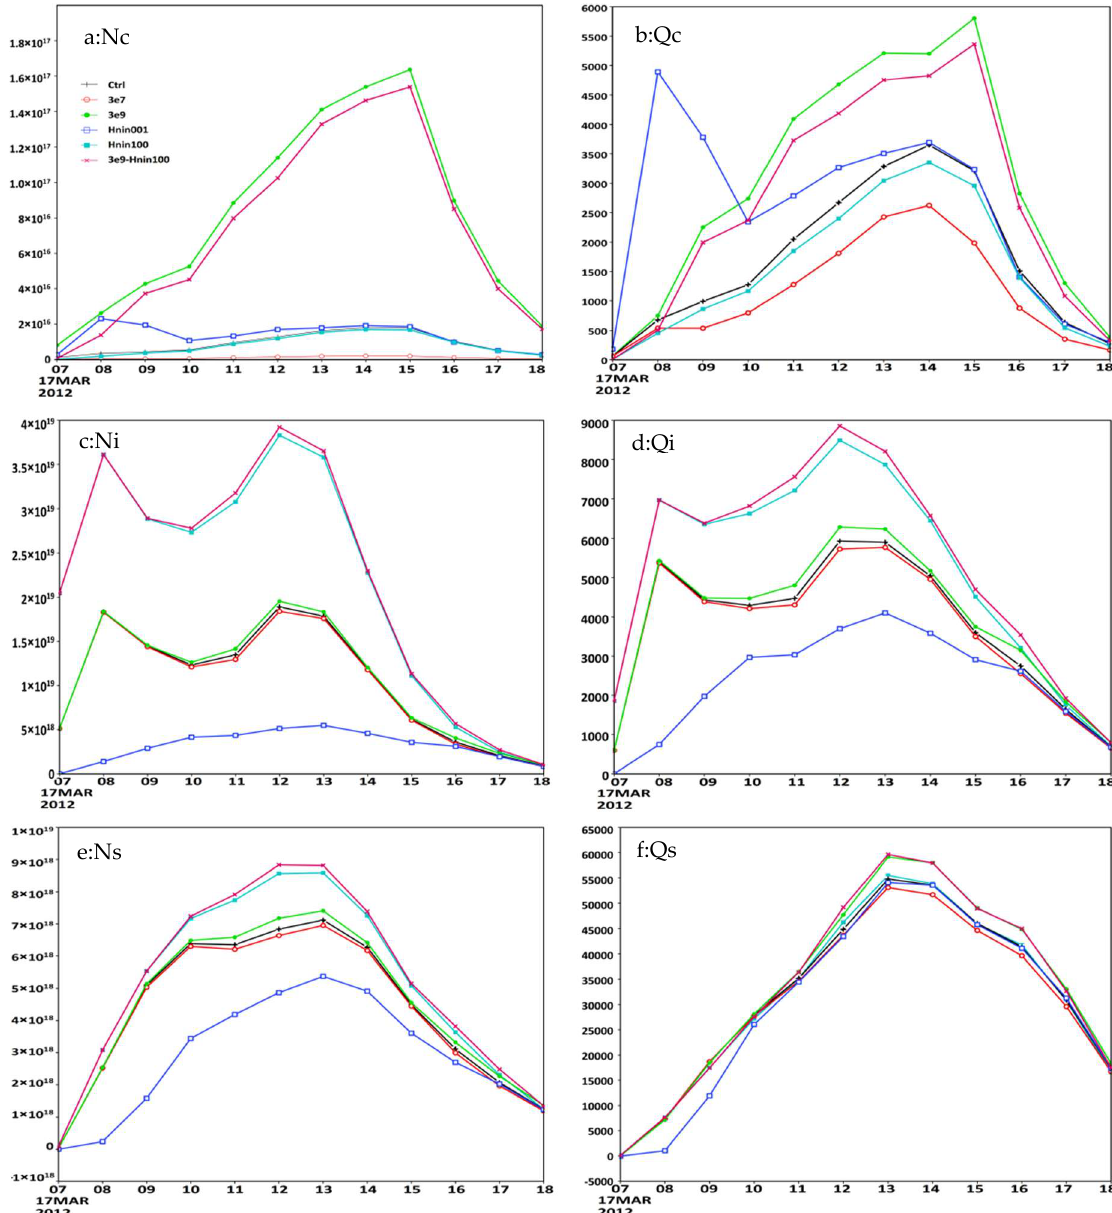
Figure 4. Time series of the domain below 10 km height accumulated of Nc ( a ), cloud mass content ( b ), ice number concentration ( c ), ice water content ( d ), snow number concentration ( e ), and snow mass content ( f ); six lines represent the control and five sensitivity experiments.